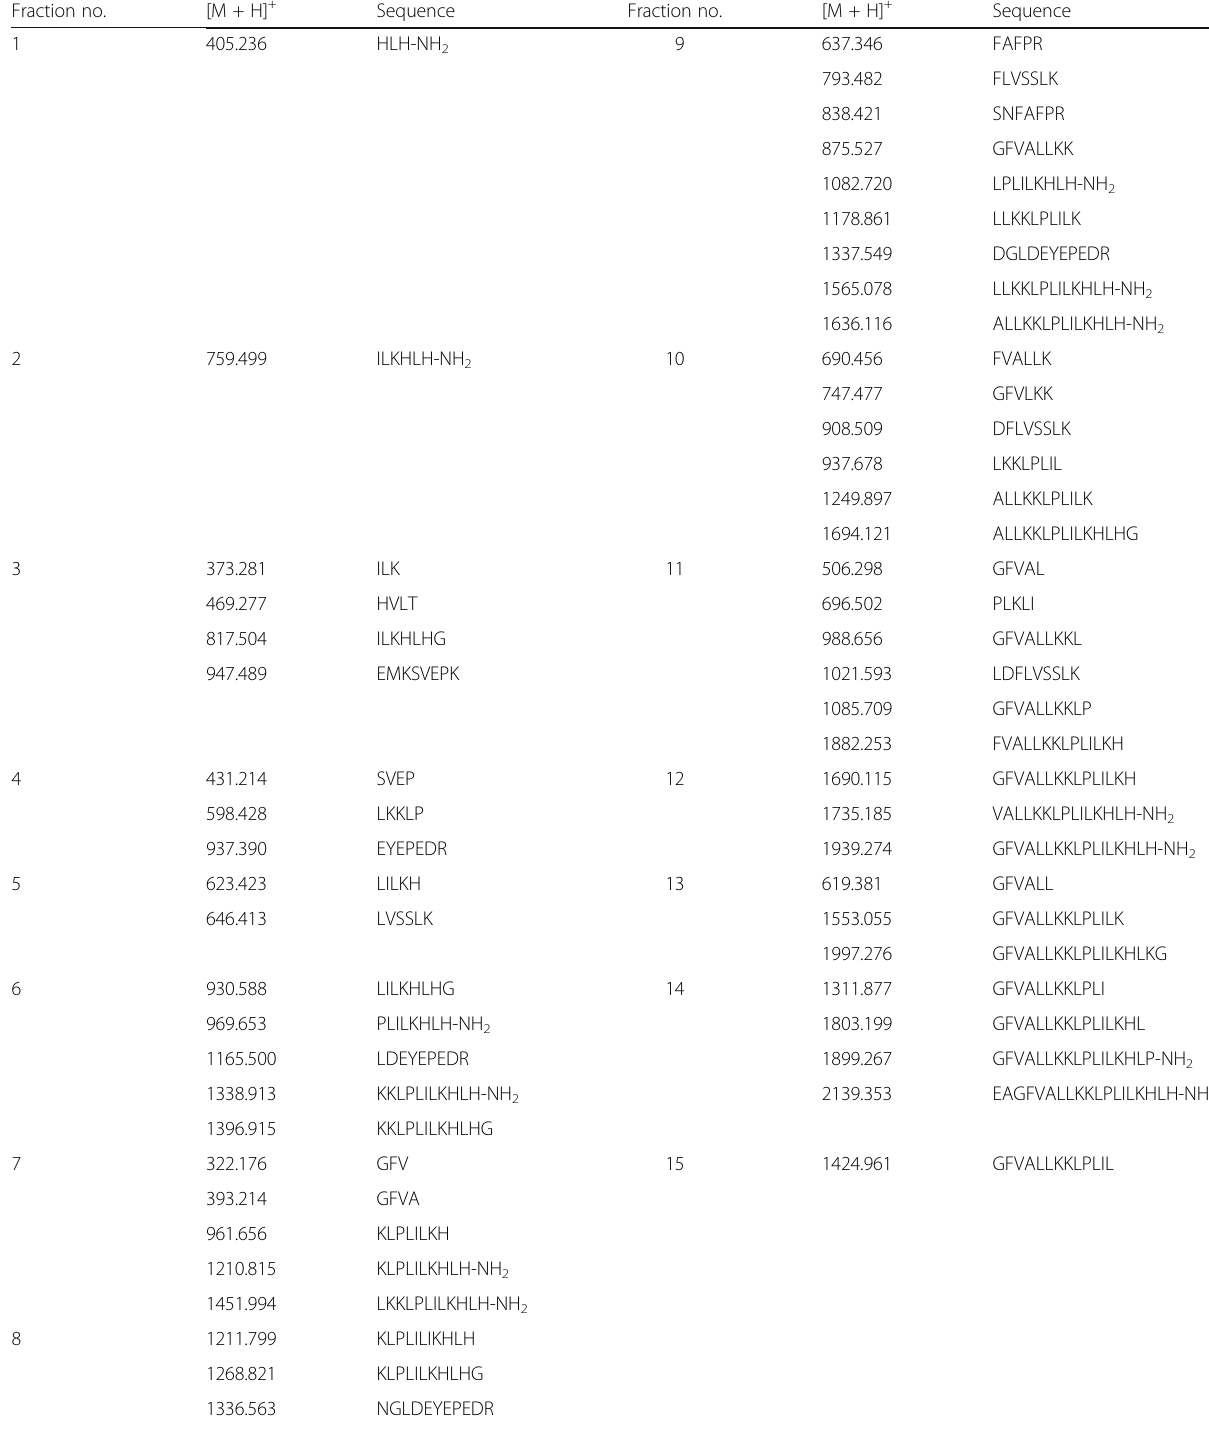
Table 3 Peptide sequences analyzed from MS/MS spectra Fraction